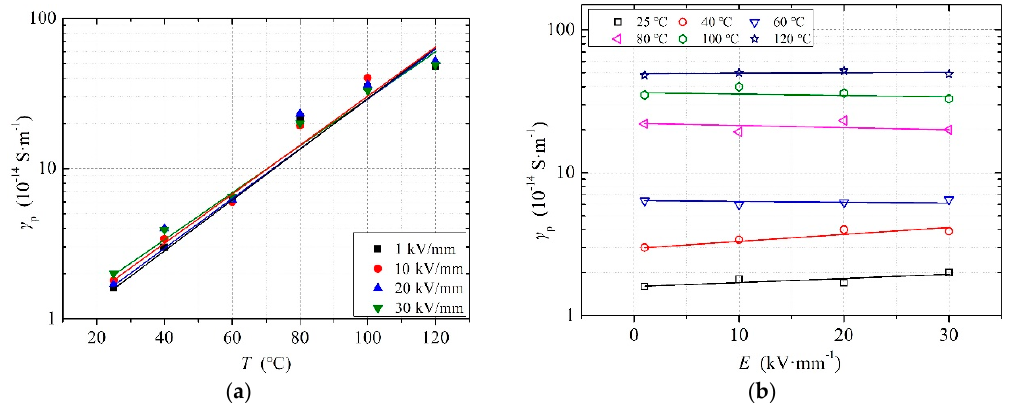
Figure 5. Relationship between pressboard conductivity and temperature/electric field strength ( w = 0.9%): ( a ) Temperature as the x coordinate; ( b ) Electric field strength as the x coordinate.